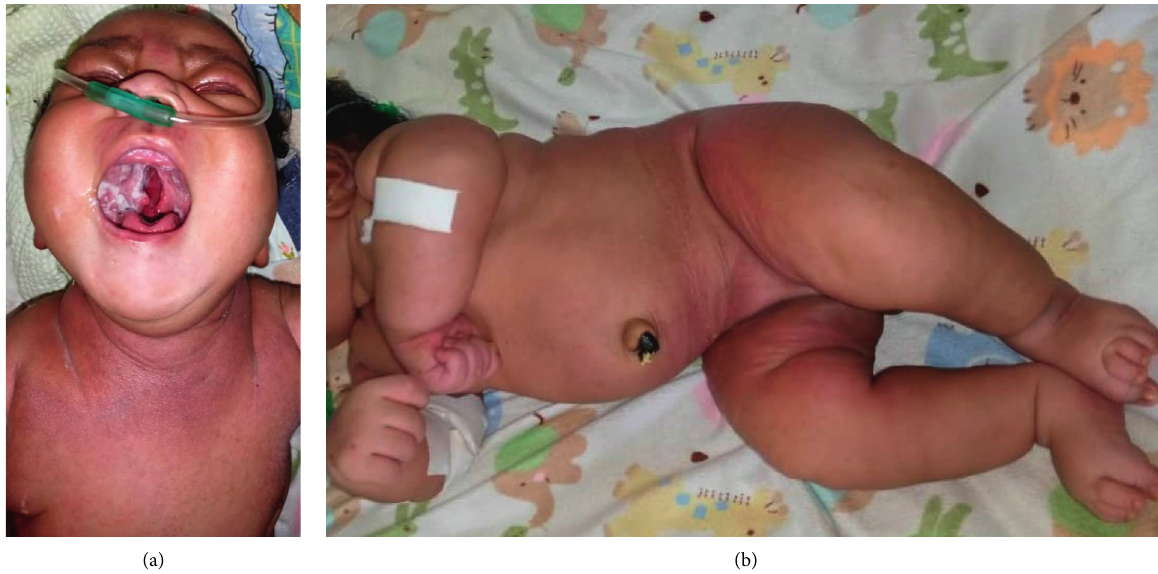
Figure 1: Photographs of the neonate with a cleft palate and diffusely indurated purplish skin in the neck region (a), thighs, buttocks, and groin (b) that could not be pinched or